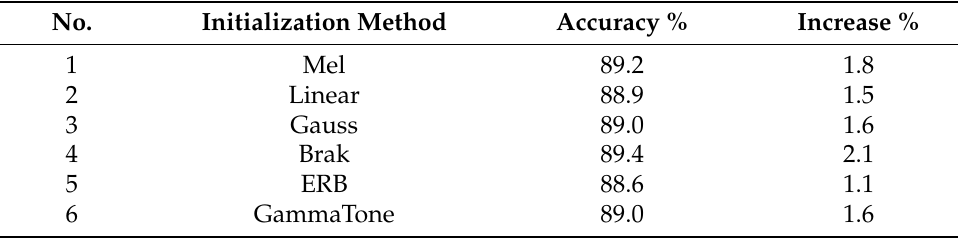
Table 6. The effect of different initialization methods on the M 1